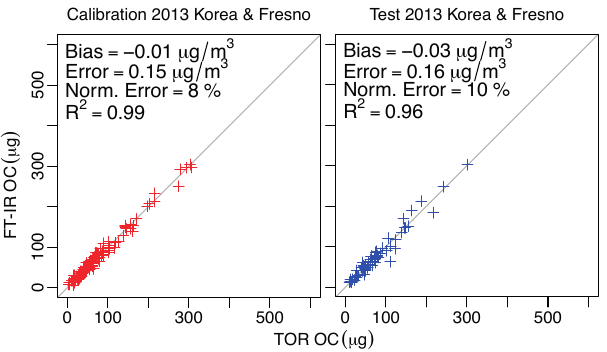
Figure 7. Scatter plot and performance metrics between FT-IR OC and TOR OC of the Korea and Fresno sites (site ID 10 and 11 re- spectively). A new calibration set, based on two-thirds of the ambi- ent samples collected at these two sites in 2013, is used for a ded- icated model. Concentration units of µgm − 3 for bias and error are based on the IMPROVE nominal volume of 32.8m 3